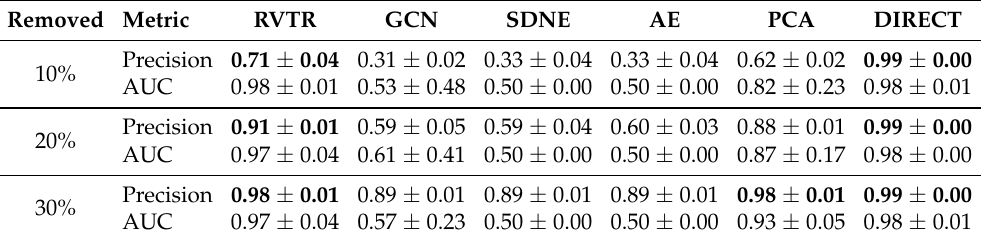
Table 2. The prediction results by different methods tested on the network of 1000. The tests were performed on 10%, 20% and 30% nodes removed,